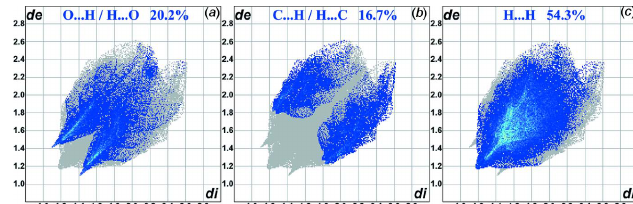
Figure 4 Contributions of the O (cid:2)(cid:2)(cid:2) H/H (cid:2)(cid:2)(cid:2) O ( a ), C (cid:2)(cid:2)(cid:2) H/H (cid:2)(cid:2)(cid:2) C ( b ) and H (cid:2)(cid:2)(cid:2) H ( c ) contacts to the fingerprint plots built using the Hirsfeld surfaces of conformer A .